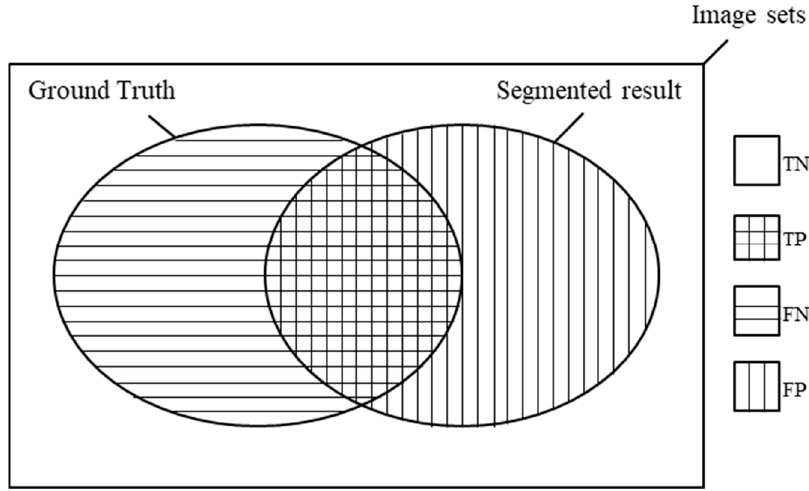
Figure 6. Illustration of evaluation metrics for image segmentation.